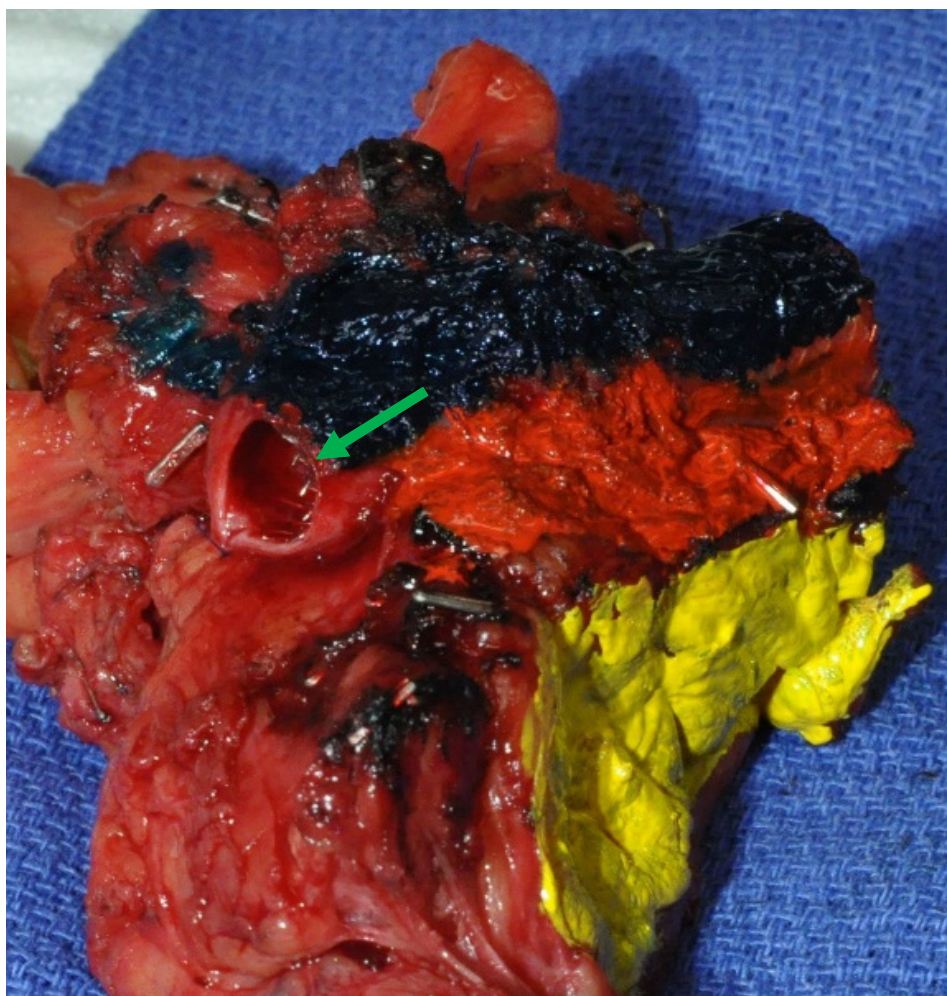
Figure 1. Pancreaticoduodenectomy specimen with long (8 cm) portal vein resection in a patient with locally advanced PDAC who received Folfirinox induction. A metallic stent (green arrow) was inserted preoperatively into the portal vein because of complete stenosis. The specimen was inked by the surgeon in the operating room; the venous, arterial, and retroperitoneal margins were inked in blue, red, and yellow, respectively.